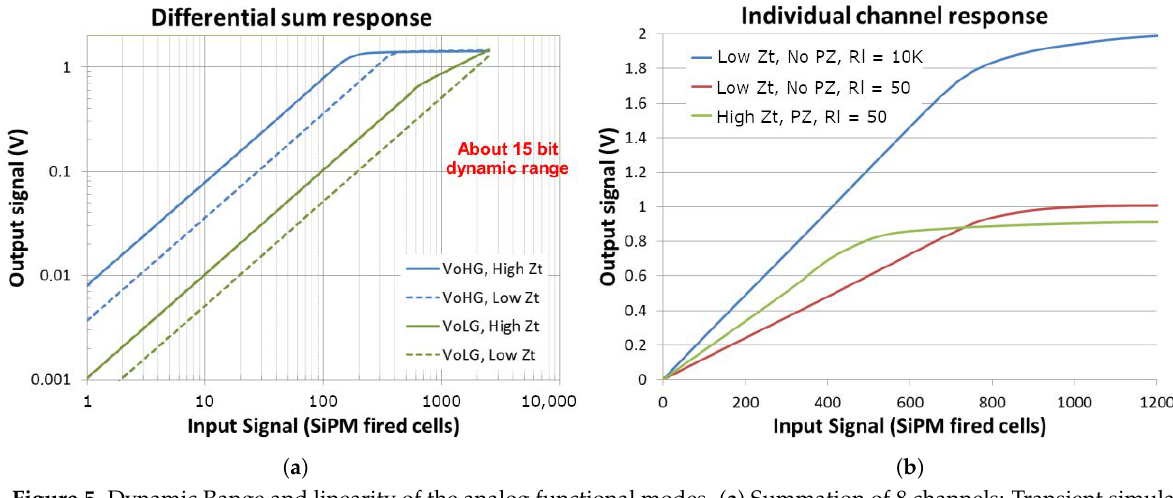
Figure 5. Dynamic Range and linearity of the analog functional modes. ( a ) Summation of 8 channels: Transient simulation using an input cell signal normalized to 12 µ A current peak per cell. ( b ) Individual readout: Transient simulation using an input cell signal normalized to 8 µ A current peak per